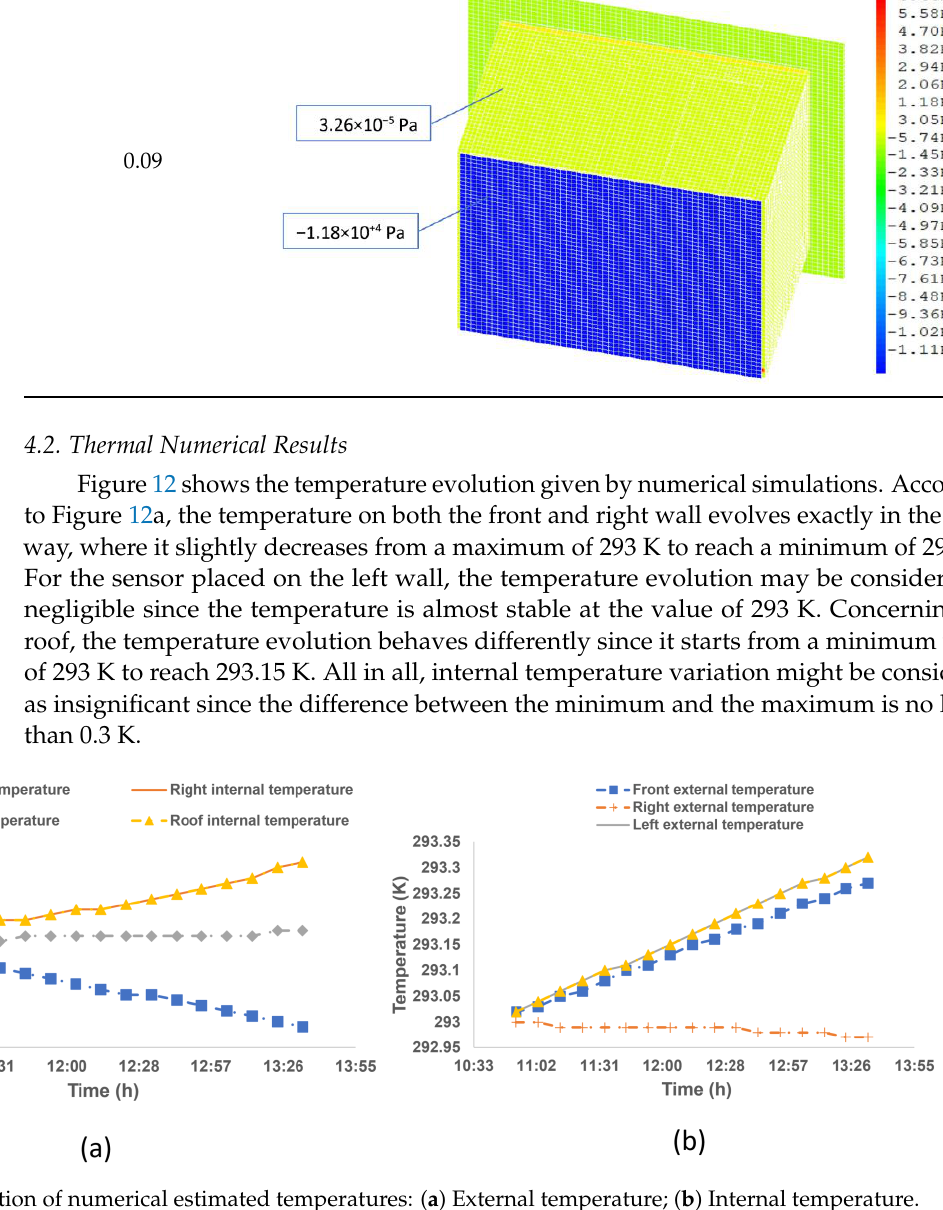
Figure 12. Time evolution of numerical estimated temperatures: ( a ) External temperature; ( b ) Internal temperature.